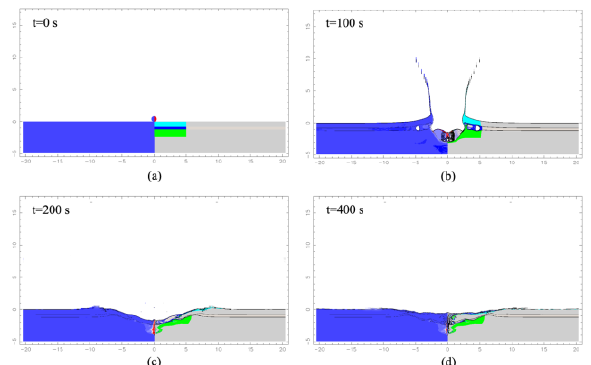
Figure 4. Projectile impacting at 12.8 km/s for layered ice basalt target under Martian gravity